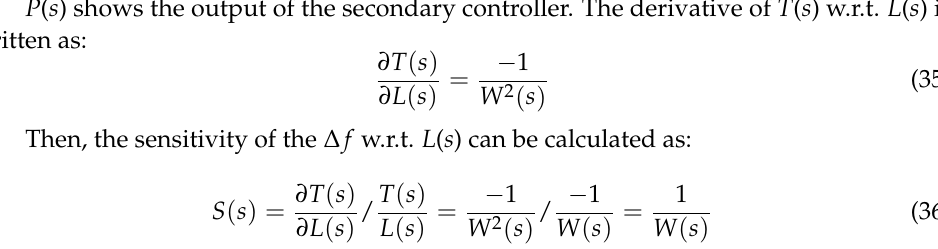
Figure 17. Sensitivity analysis of the MG by employing the proposed controller during ±25% varia- tions in ( a ) T g and ( b ) T FC .